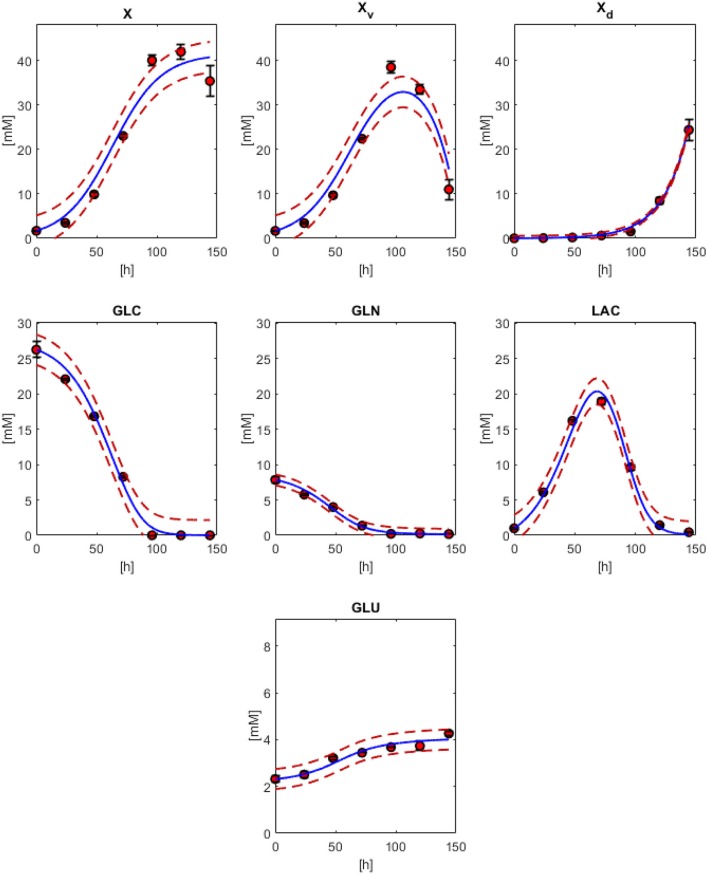
Physiological modeling results compared to experimental data. biomass models with Equations (1) (X), 3 (Xv) and 2 (Xd). Models for GLC (Equation 10), GLN (Equation 11), LAC (Equation 12), and GLU (Equation 13). Red dashed lines are the confidence curves for each model.